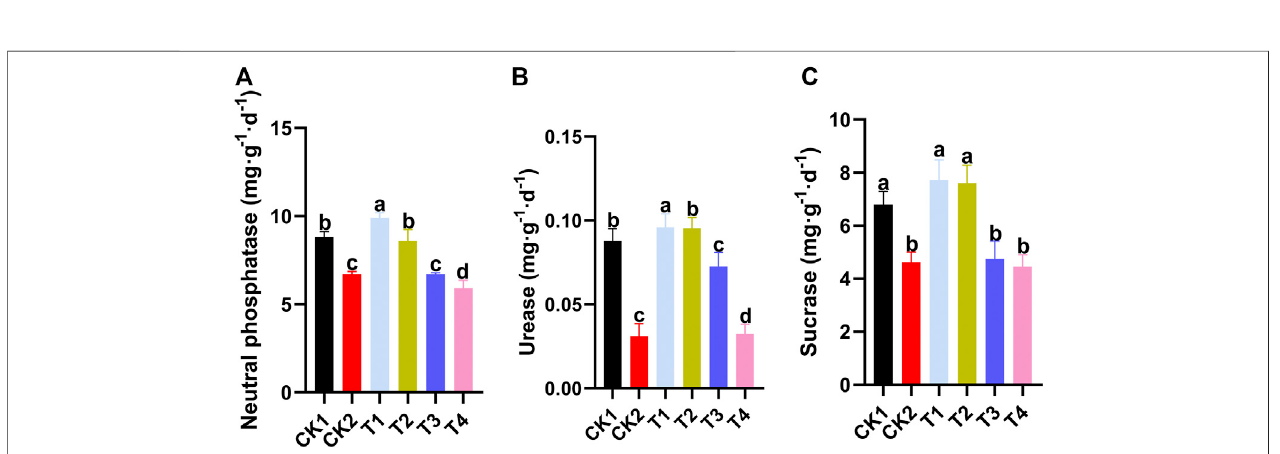
FIGURE 7 | Effect of different treatment methods on soil enzyme activity. (A) Neutral phosphatase activity. (B) Urease activity. (C) Sucrase activity. CK1: control, CK2: high standard control, T1:foliar spraying, T2:foliar soaking, T3: root soaking, T4: soil soaking. The different letters above the bar indicate that there is a signi fi cant difference between the mean values of different treatments using one-way ANOVA and Duncan ’ s multiple range test ( p < 0.05). Error bars indicate ± S.E. (n = 3).